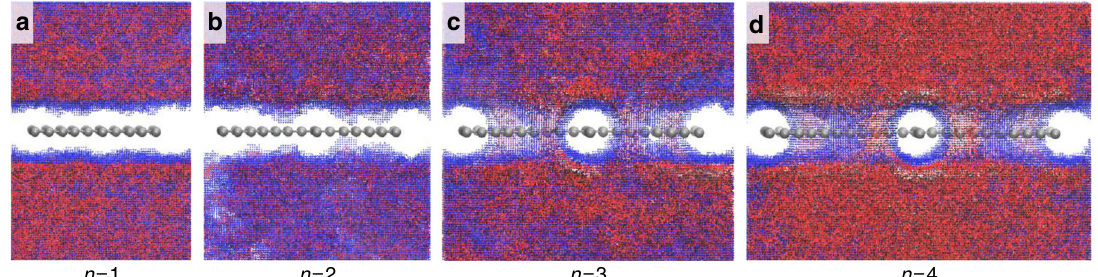
Fig. 3 Water distribution surrounding graphyne. a n = 1 b n = 2 c n = 3 d n = 4. The red and blue dots represent the density of oxygen and hydrogen element,